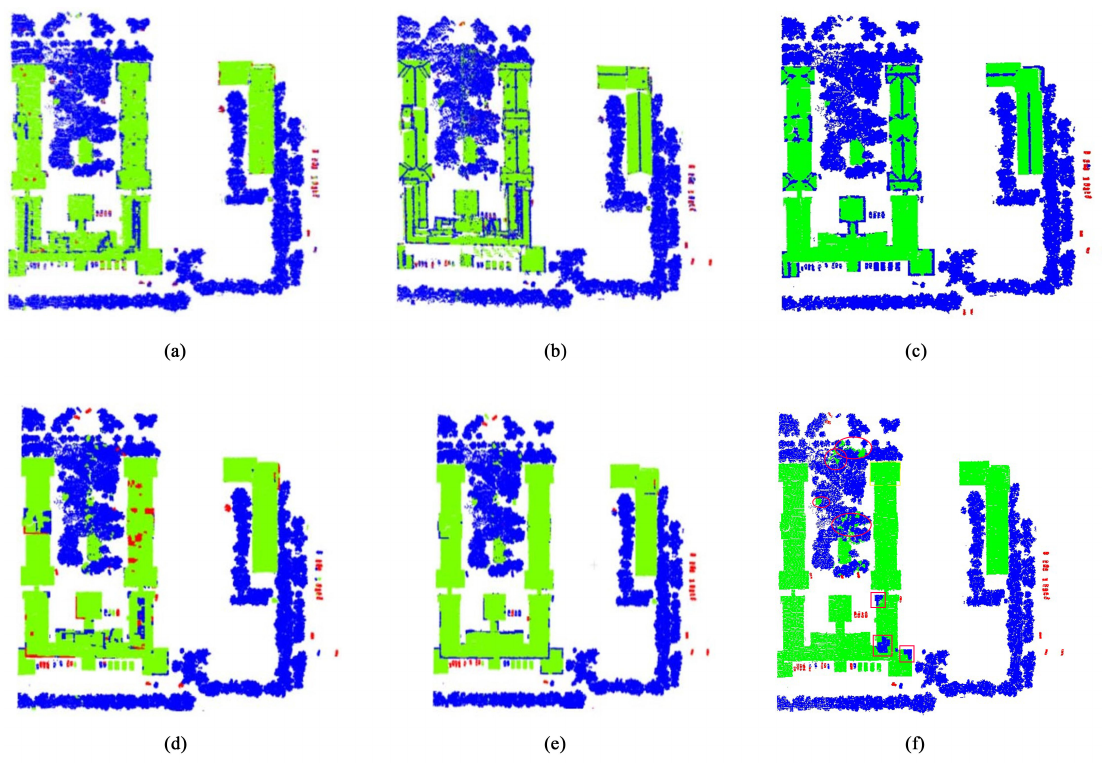
Figure 6. Comparison of the performance of six methods of classifying a residential scene. Subfigures ( a – e ) are the results generated by the state-of-the-art Methods 1 to 5. Our results are shown in ( f ). The color legend is defined in Figure 2.